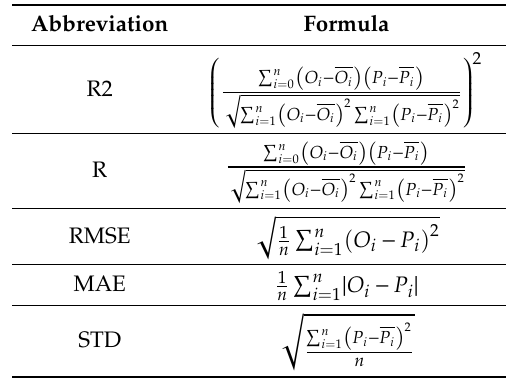
Table A2. Mathematical expressions of the goodness of validation.